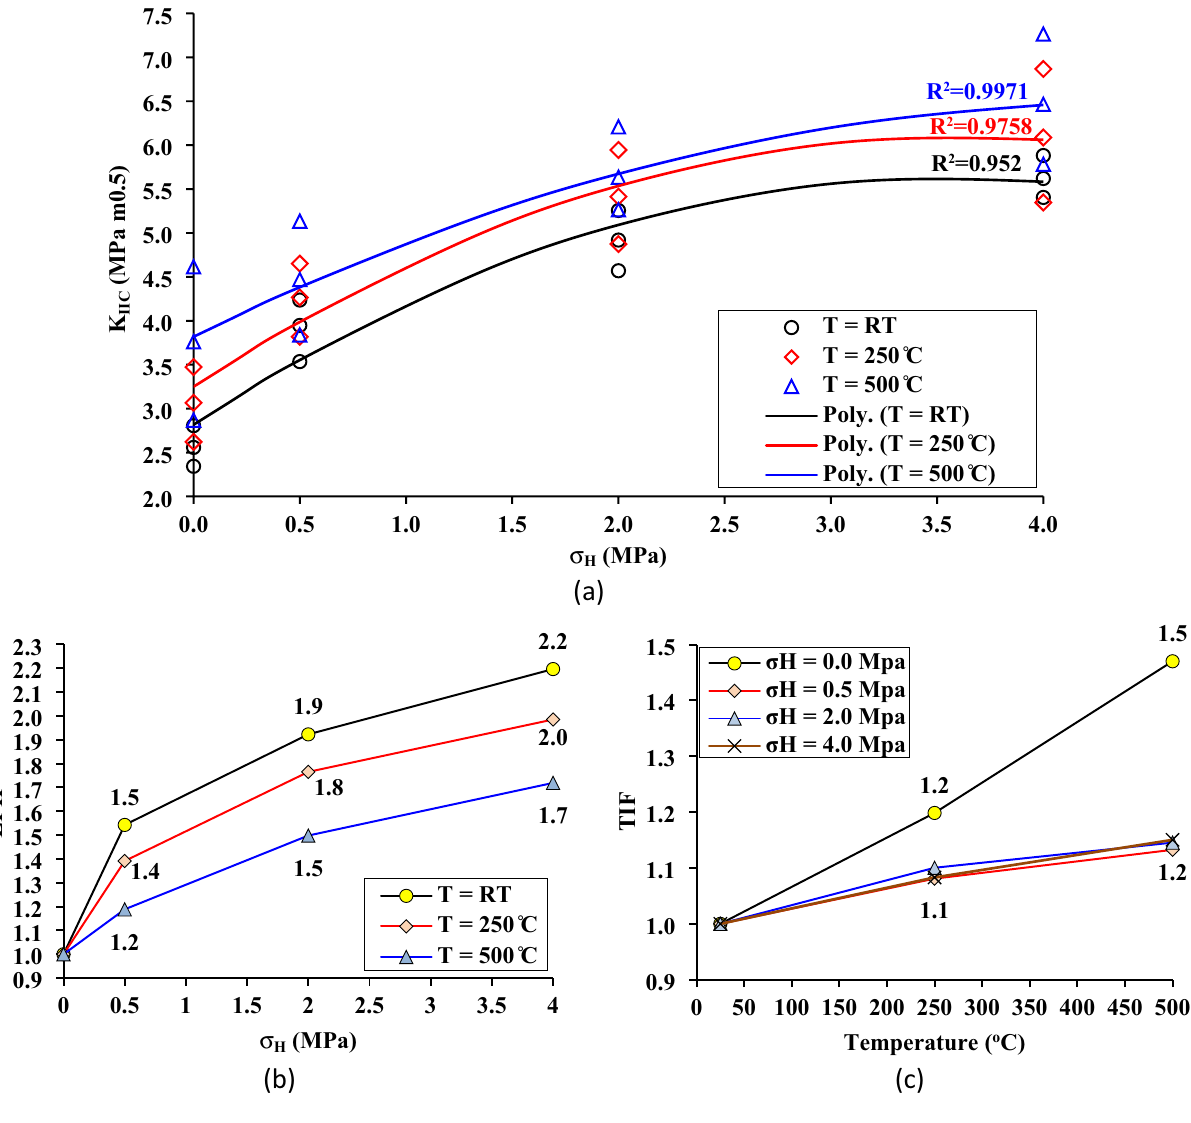
Figure 9. Fracture toughness, ( a ) fracture toughness as a function of the temperature and lateral pressure, ( b ) lateral pressure increasing factor (LPIF), ( c ) temperature increasing factor